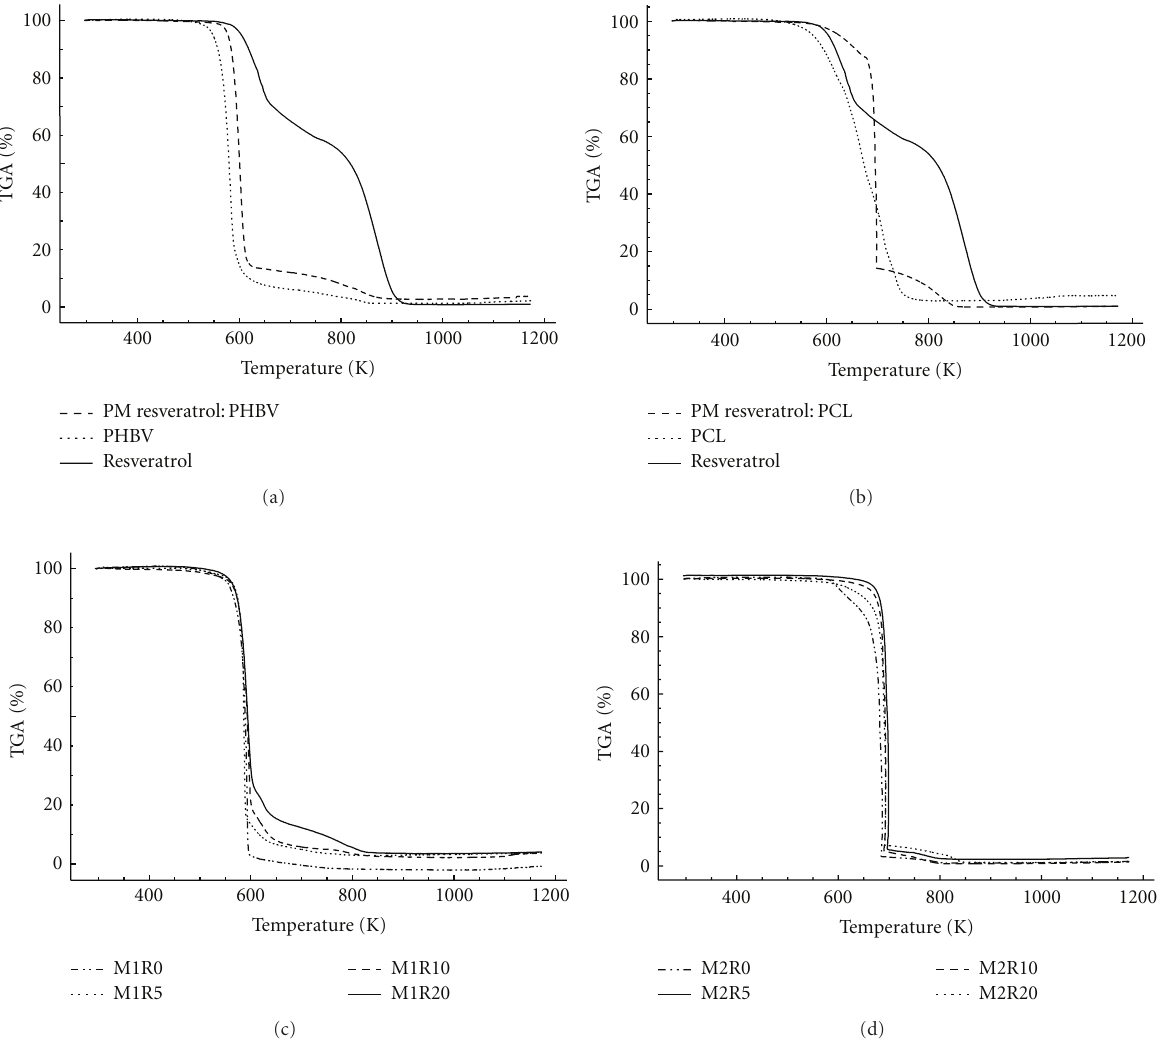
Figure 6: TG curves of resveratrol, PHBV/PCL and physical mixtures (a) and (b), PHBV microparticles (c), and PCL microparticles (d).